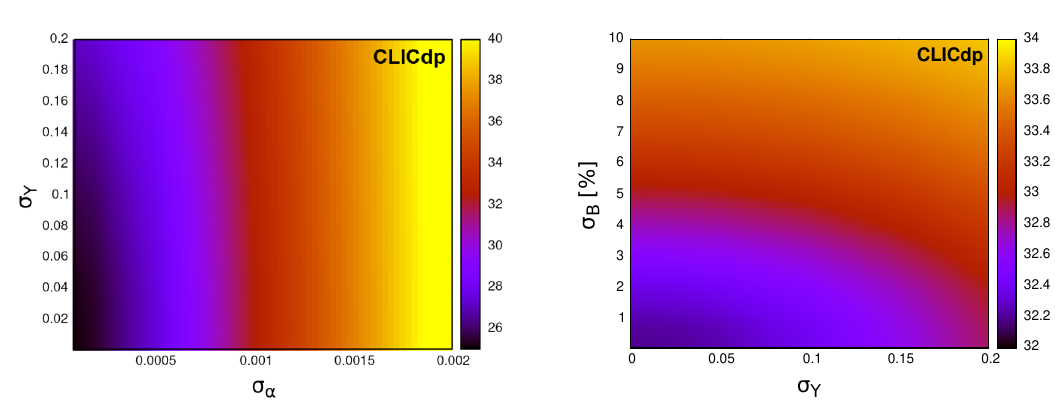
Figure 8 . Expected uncertainty on the top-quark mass from the fit involving all considered model parameters (5D). Left: as a function of the strong coupling constant and Yukawa coupling uncer- tainties, assuming background uncertainty of 2% and normalisation uncertainty, ∆ = 1% . Right: as a function of the background and Yukawa coupling uncertainties assuming strong coupling un- certainty of 0.001 and normalisation uncertainty, ∆ = 1% .